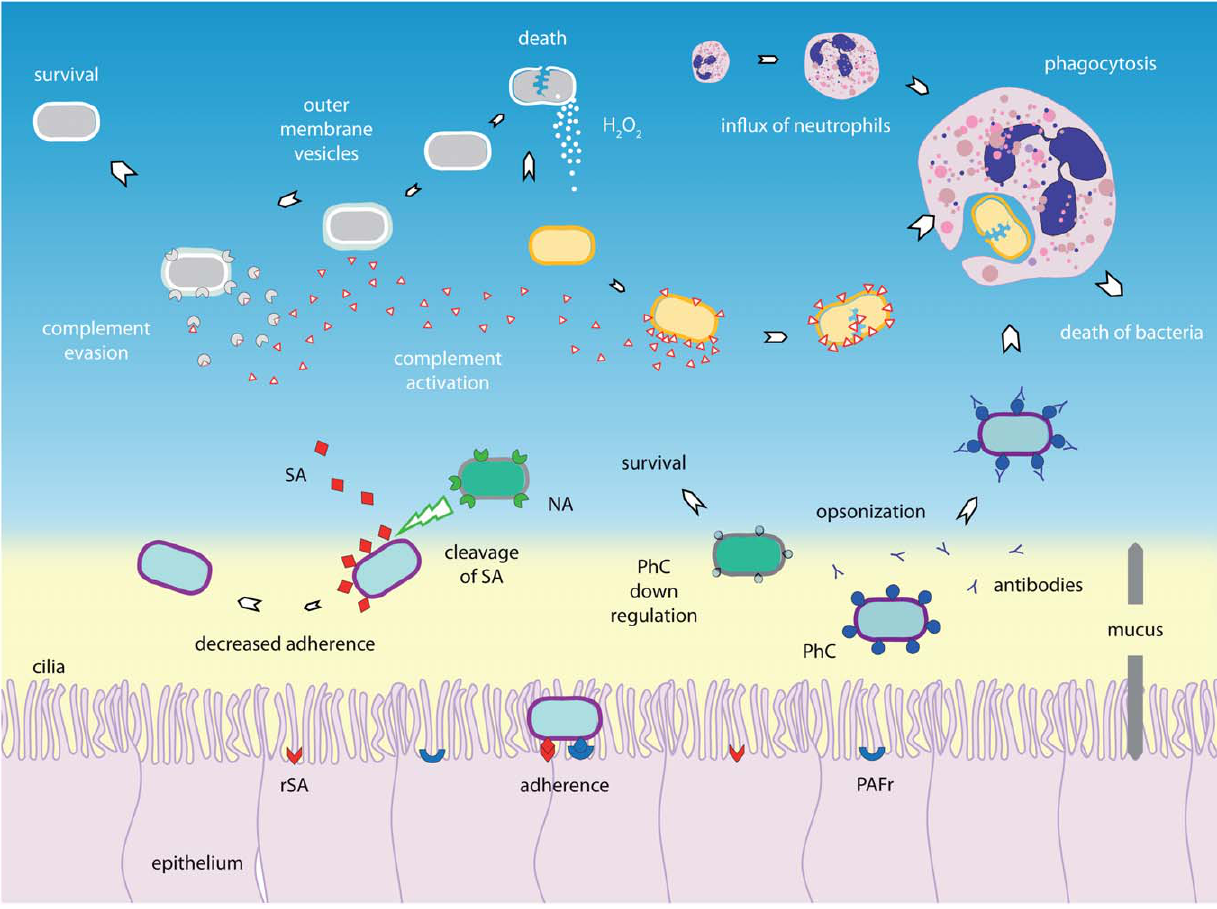
Figure 1. Bacterial–bacterial interactions. The composition of nasopharyngeal microbiota is constantly subject to interactions between species. Bacterial species can interact with other bacterial species by competition and synergism. Synergism can be characterized by, for instance, the production of components that favors another species, as shown for the production of outer membrane vesicles. These may contain factors that are able to inactivate complement factor C3, thereby allowing another species to escape the immune system. Production of substances by one species, for example hydrogen peroxide (H 2 O 2 ), may eliminate its competitor. The immune system may also be involved in competition, as one bacterium has fewer escape mechanisms to evade the immune system than another and therefore may use co-inhabitants to survive, whereas the reverse phenomenon (i.e., one species may trigger the immune system to combat the other species) may also occur. In addition, since PhC (phosphorylcholine) is shown to be immunogenic and some species may be able to switch off PhC expression whereas others cannot, there might be a selective advantage. Another form of competition involves competition for the same host receptor, as demonstrated for PhC and its receptor platelet activating factor receptor (PAFr). Moreover, one species may use neuraminidase to cut off the sialic acids (SA) that other bacteria may require for attachment to host receptors, therefore inhibiting adherence of the other bacterial species. H 2 O 2 , hydrogen peroxide; PAFr, platelet activating factor receptor; PhC, phosphorylcholine; NA, neuraminidase; SA, sialic acid (SA); rSA, receptor for sialic acids; Ab,